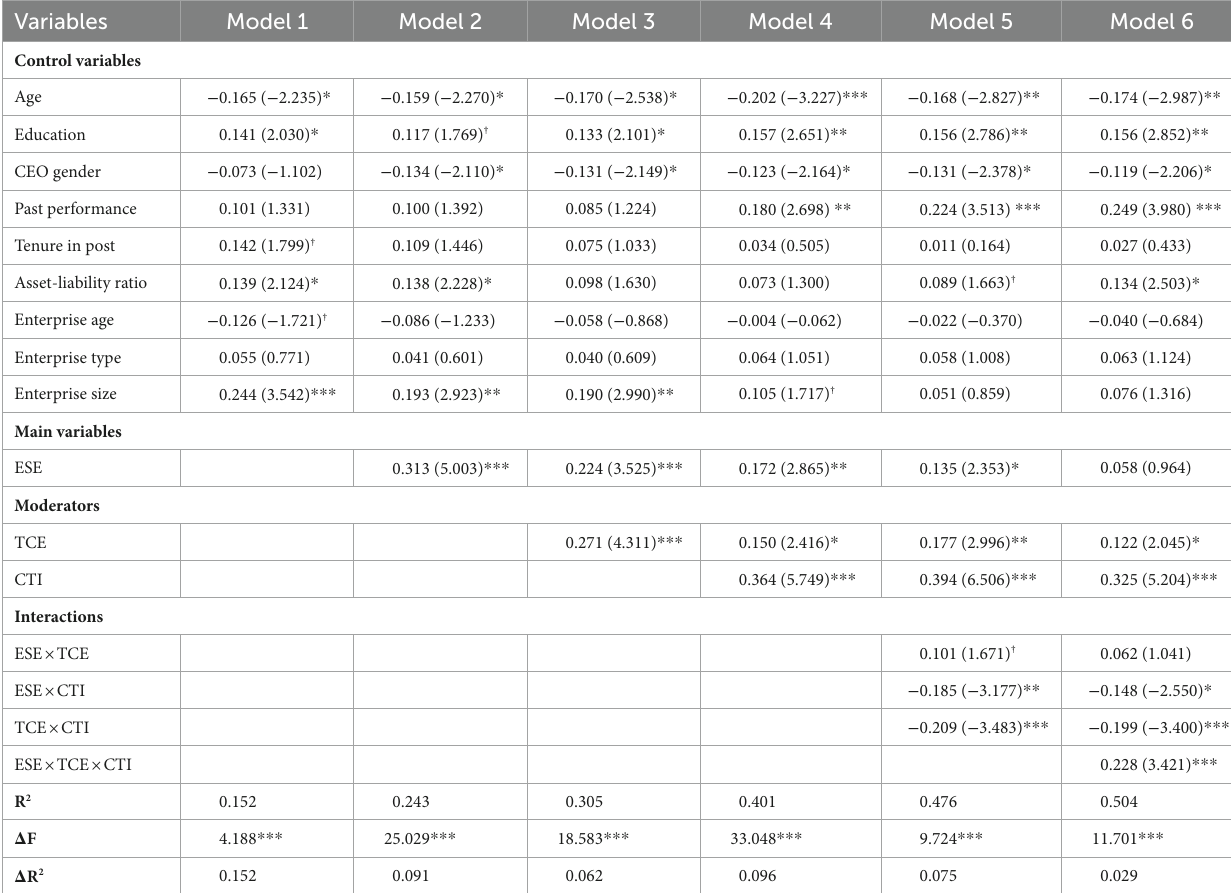
TABLE 4 Results for hierarchical regression